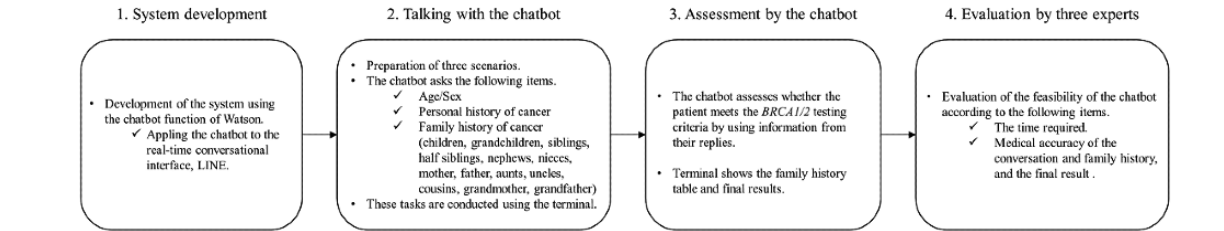
Figure 4. The algorithm of the study.